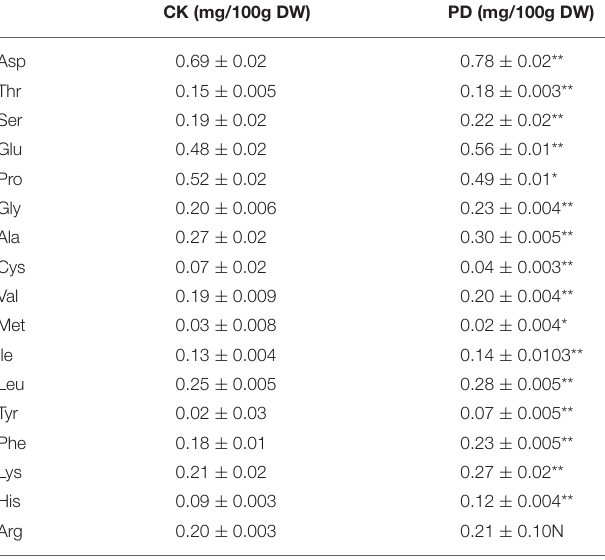
TABLE 1 | Classification of metabolites with significant difference between CK and RD peels. Classification